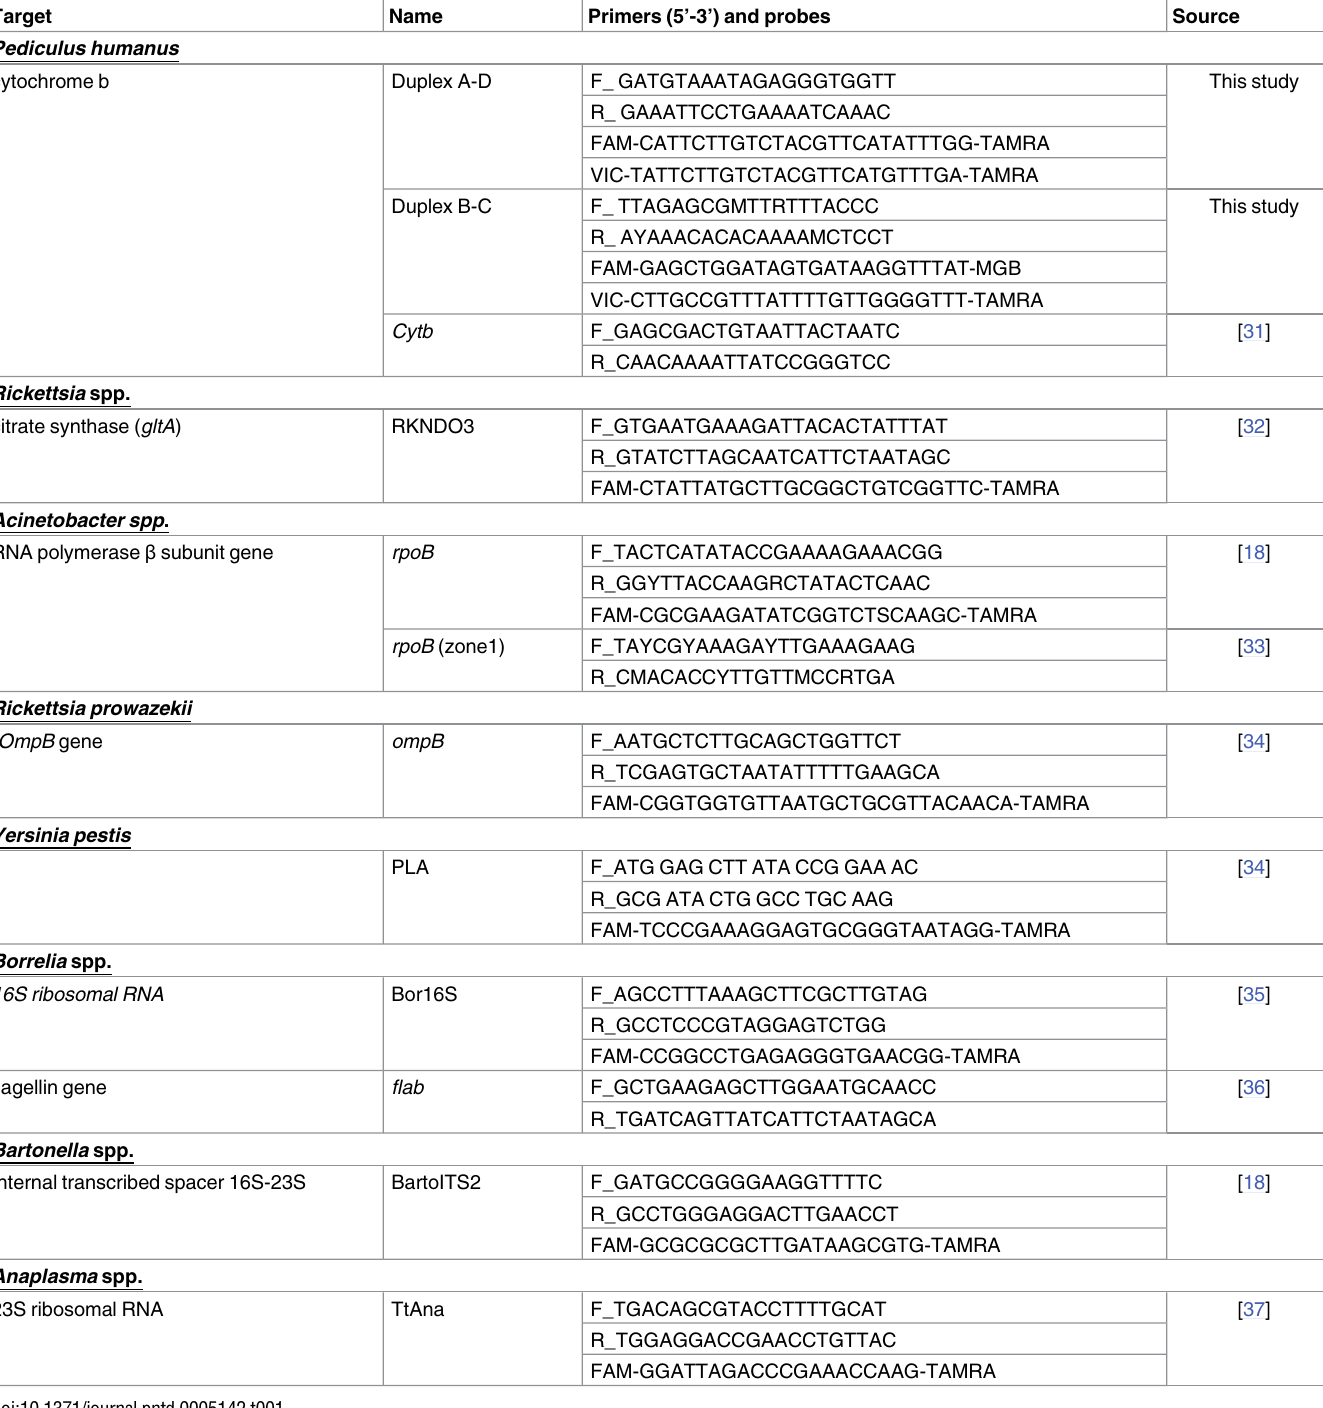
Table 1. Oligonucleotide sequences of primers and probes used for real-time PCRs and conventional PCRs in this